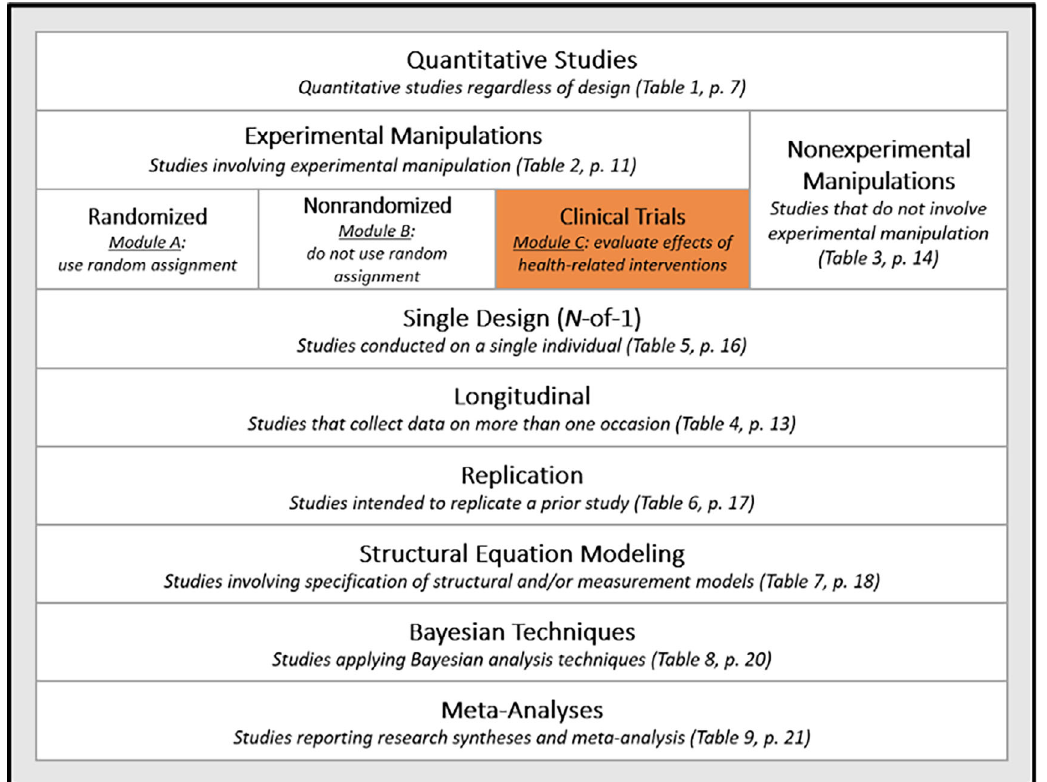
Figure 2. The APA Journal Article Reporting Standards (JARS) by study design summary. Note. Figure adapted from Appelbaum et al. (2018, Tables 1-9). APA JARS recommendations are outlined in a series of tables and modules addressing varying quantitative study designs; a singular table or combination of tables may apply to a given research report. Please note that Figure 2 includes current APA guidance released as of 2018; new tables may be added over time, please visit https://apastyle.apa.org/jars/quantitative for more